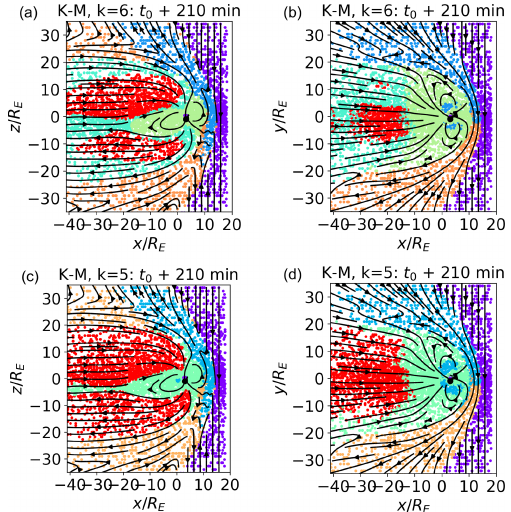
Figure B2. The k-means classification with k = 6 (a, b) and k = 5 (c, d) for the data points in the meridional (a, c) and equatorial (b, d) planes. The training data set is